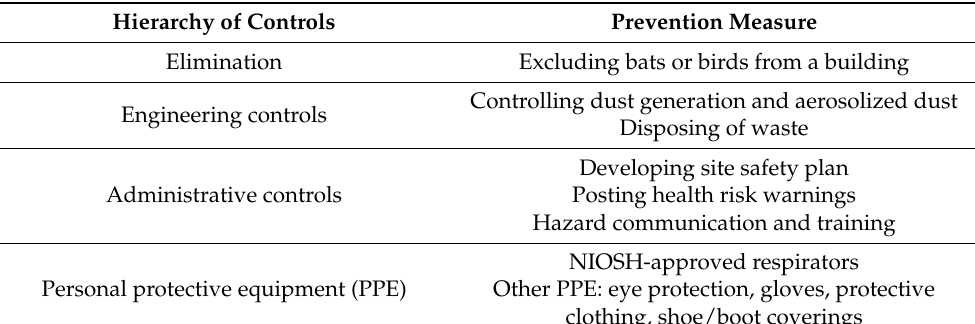
Figure 1. The hierarchy of controls for controlling exposures to occupational hazards. This framework is presented with the methods at the top of graphic as more effective and protective than those at the bottom. Source: National Institute for Occupational Safety and Health (NIOSH). Table 2. Measures to prevent Histoplasma exposures in the workplace.